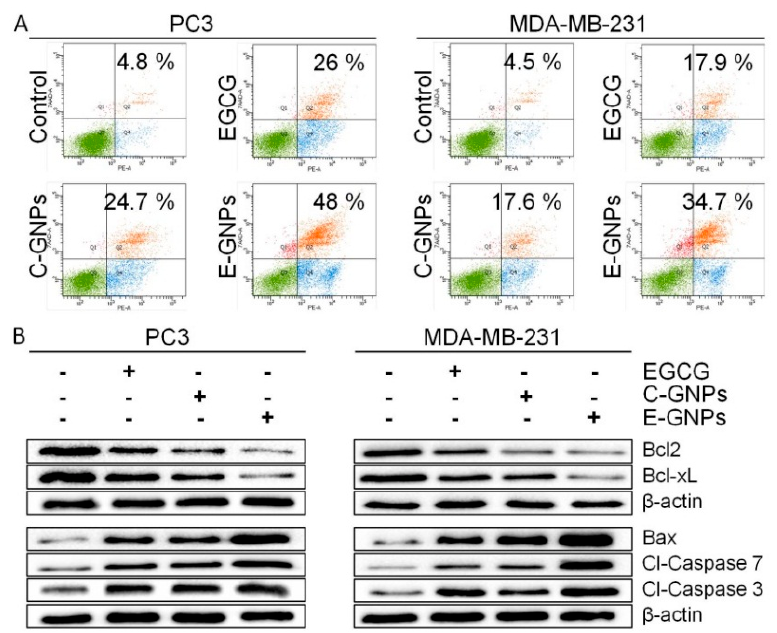
Figure 6. E-GNPs induce apoptosis in cancer cells. ( A ) The number of apoptotic cells after treatment with EGCG, C-GNPs, and E-GNPs was determined by Annexin V binding assay, using flow cytometry. ( B ) Total protein was isolated and immunoblot analysis was performed to analyze the expression of BCL2, BCL-xL, Bax, cleaved-caspase 7, and cleaved caspase 3. β -actin was used as loading control.